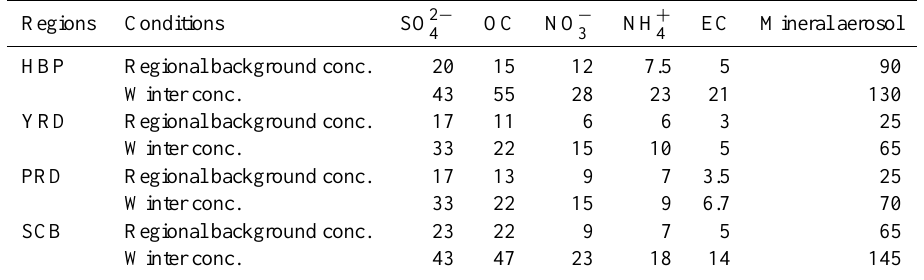
OC NO − NH + EC Mineral aerosol 4 3 4